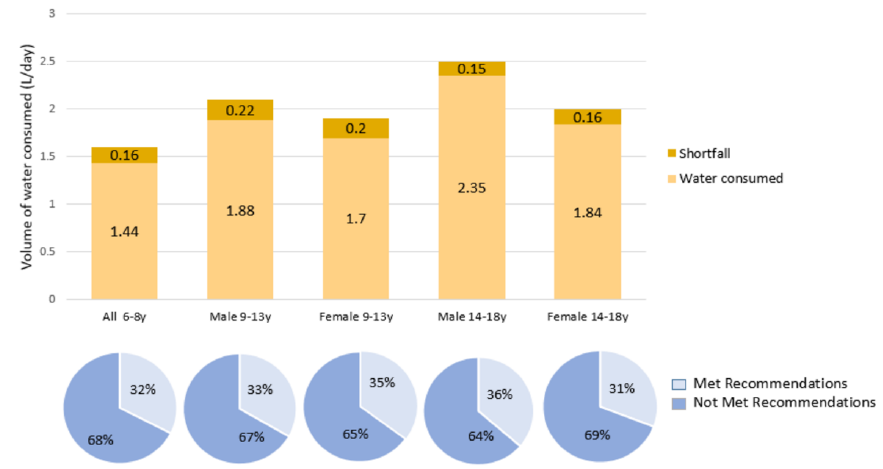
Figure 3. Comparison of water intake between study participants and European Food Safety Authority